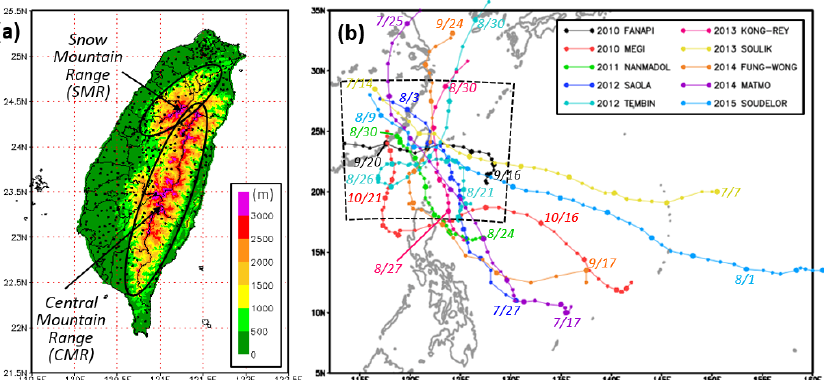
Figure 1. ( a ) The topography of Taiwan (m, color) and distribution of rain gauges (dots), with the two major mountain ranges (CMR and SMR) labelled. ( b ) CWB best tracks of the 10 typhoons during 2010–2015 included in this study, with their center positions given every 6 h (at 0000, 0600 UTC, etc., dots, those at 0000 UTC enlarged). The model domain in 2012–2015 is also shown (dashed box).